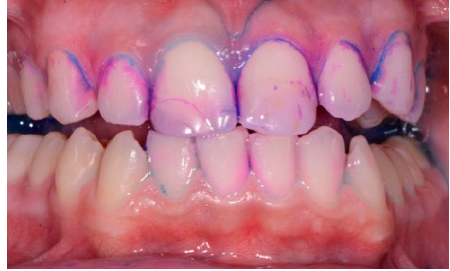
Figure 5. Oral biofilm detection by usage of plaque detector. red/pink—indicated a recently formed bacterial biofilm; blue/purple—indicated the presence of mature bacterial biofilm (over 48 h); light blue/blue—accurately detected the high-risk areas where the bacteria were most active, highlighting their acidic